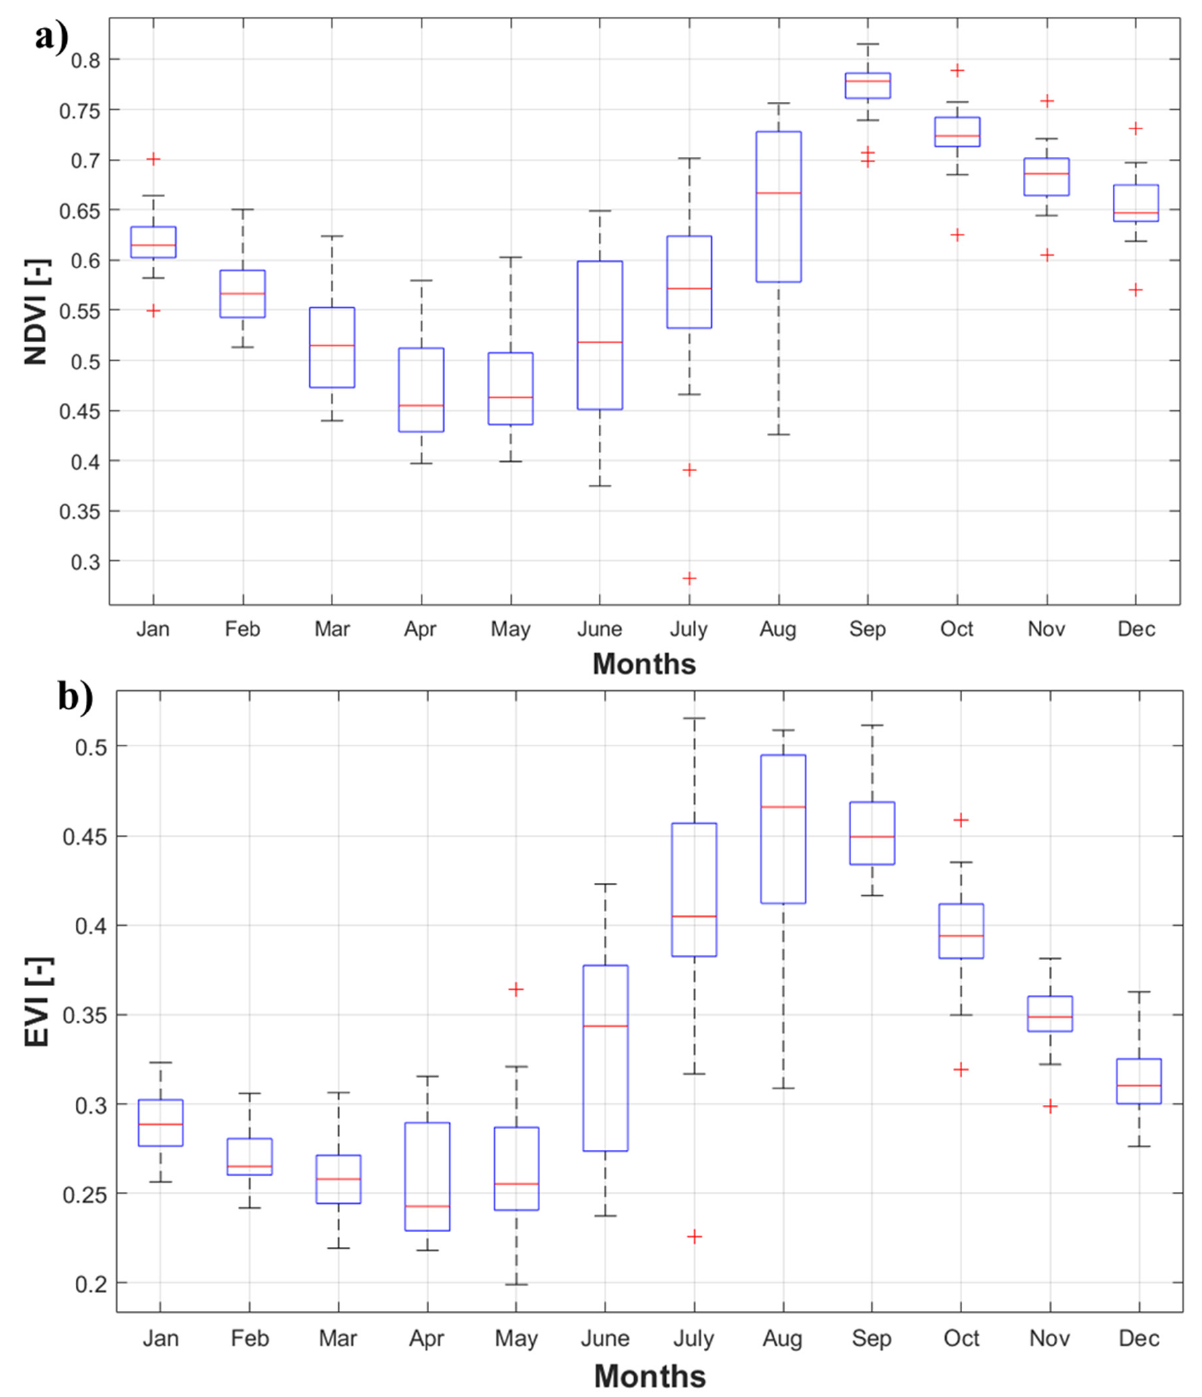
Figure 5. Mean monthly temporal variations of ( a ) NDVI and ( b ) EVI over the twenty-year period (2001–2020) for the UKR Basin.